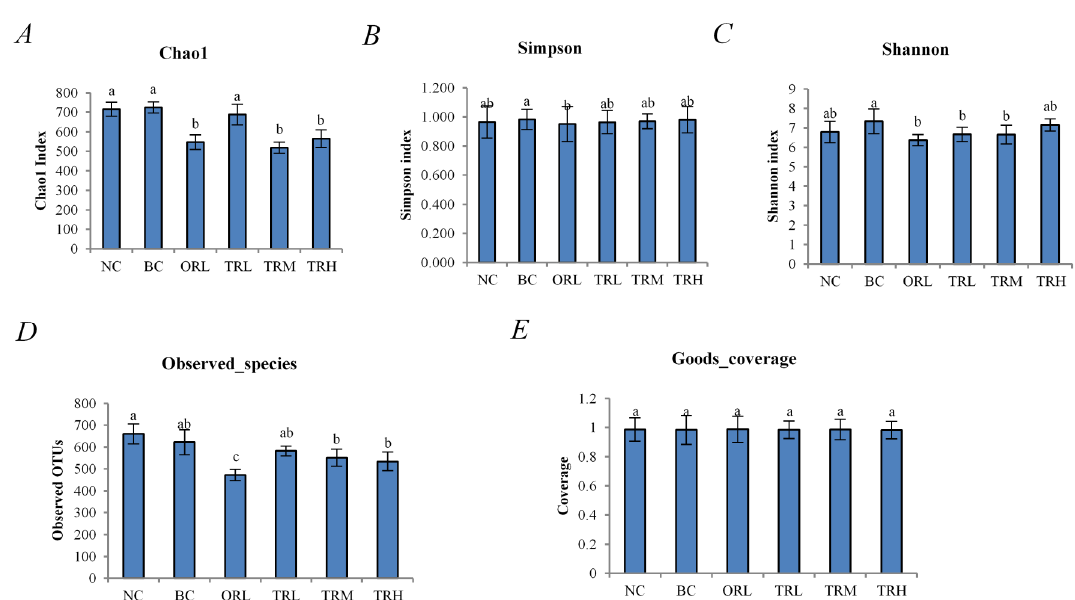
Figure 1. Alpha diversity of gut microbiota from different tested groups. ( A ) Chao1 index; ( B ) Simpson index; ( C ) Shannon index; ( D ) observed OTUs index; ( E ) Goods coverage index. Different letters indicate significant differences between groups ( p < 0.05). Differences between groups were assessed by Dunnett post hoc test after a significant one-way ANOVA ( p < 0.05). NC: Normal control group, chow diet; BC: Blank control group, high-fat diet; ORL: Positive control group, orlistat; TRL: Low-dose group, trilobatin; TRM: Middle-dose group, trilobatin; TRH: High-dose group, trilobatin.